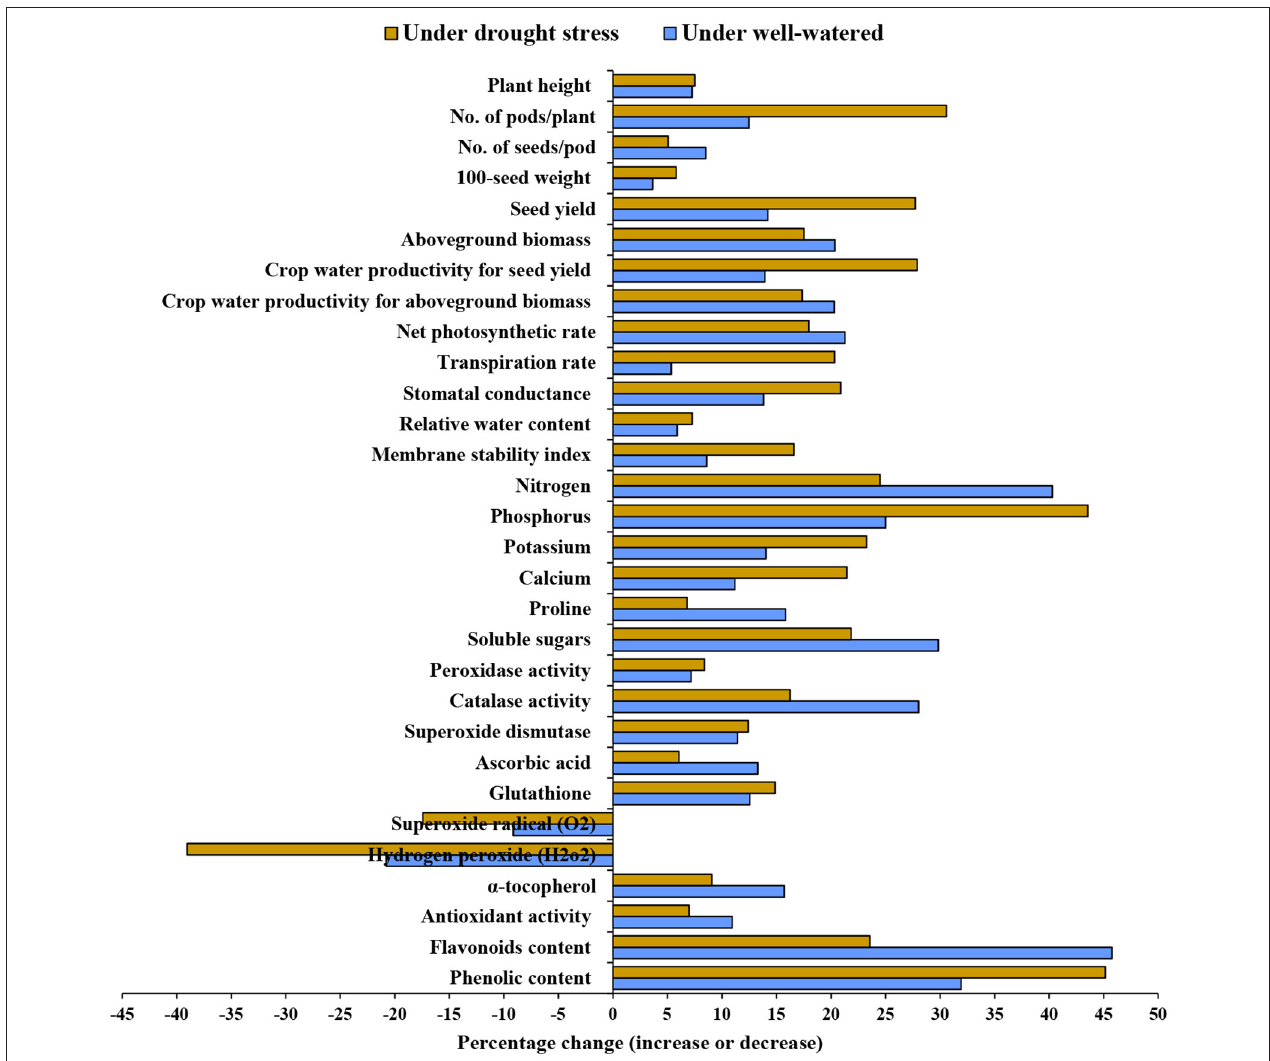
FIGURE 1 | Percentage change (increase or decrease) in morphological, agronomic, physiological, and biochemical attributes upon the application of 1.5mM nano-silicon dioxide (nano-SiO 2 ) compared with untreated faba bean ( Vicia faba ) plants under well-watered and drought-stressed